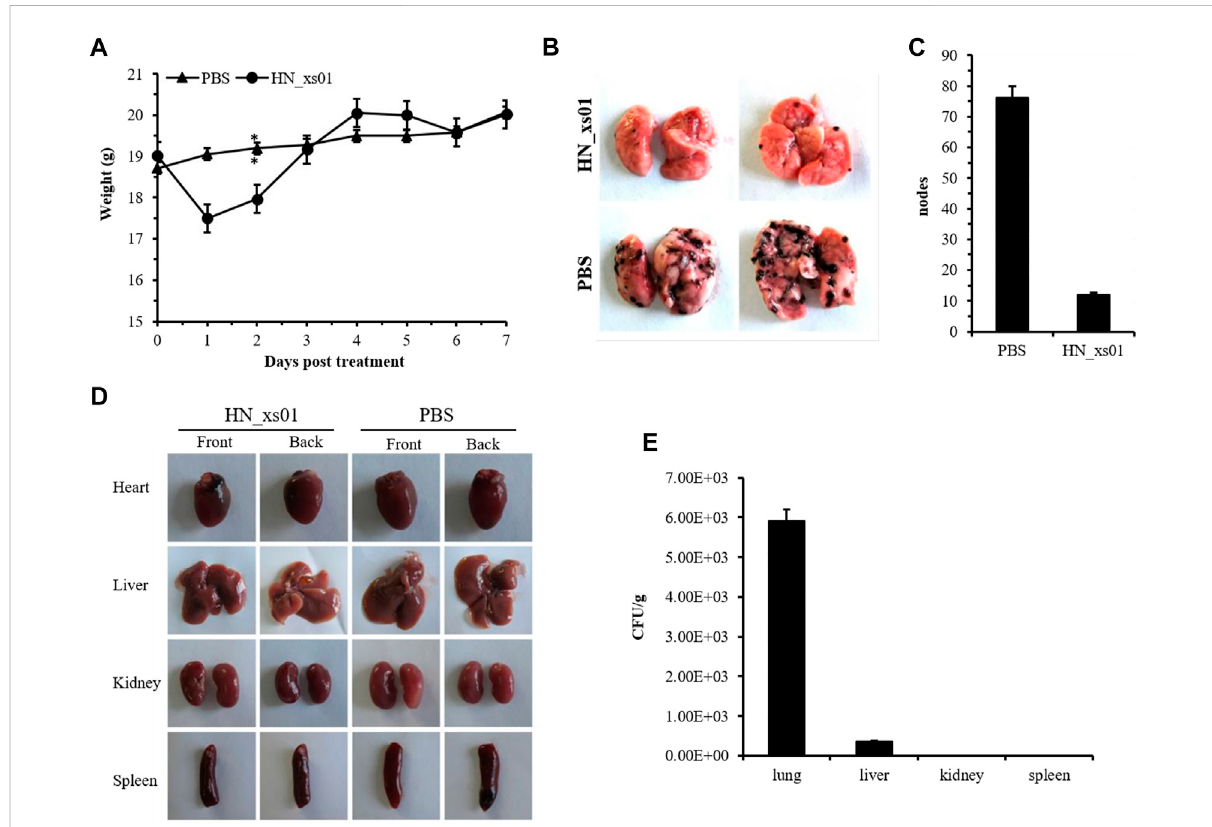
FIGURE 4 The effect of HN_xs01 on pulmonary metastasis of B16 tumors. (A) Mice with B16 tumors were injected intravenously with PBS or 5 × 10 7 CFU/ 100 μ l of HN_xs01, and body weight was measured daily. (B) The nodes distribution in the lungs of the PBS and HN_xs01 groups. After 1 week, the lungs, hearts, livers, kidneys, spleens, and tumors were isolated. (C) The nodes number in the lungs of the PBS and HN_xs01 groups. (D) The tumor nodes distribution in the heart, liver, kidney, and spleen tissues between the PBS and HN_xs01 groups. (E) Bacterial distribution in organs was calculated by CFU/g. Strain HN_xs01 mostly colonized the lung